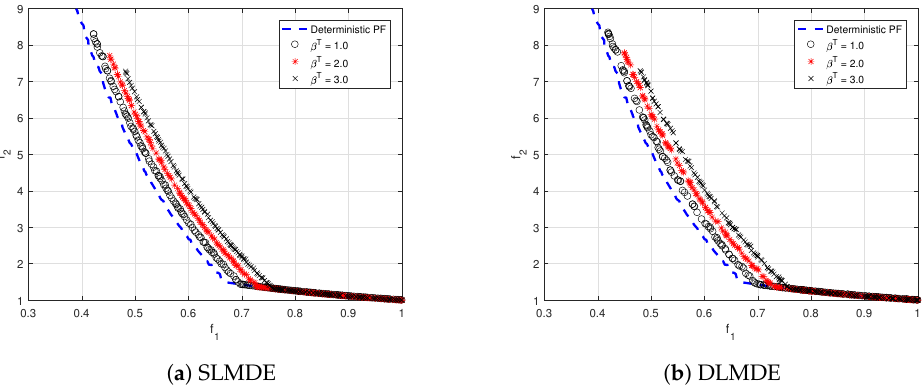
Figure 2. The obtained PO solutions by both methods for example 1 for different β T values.